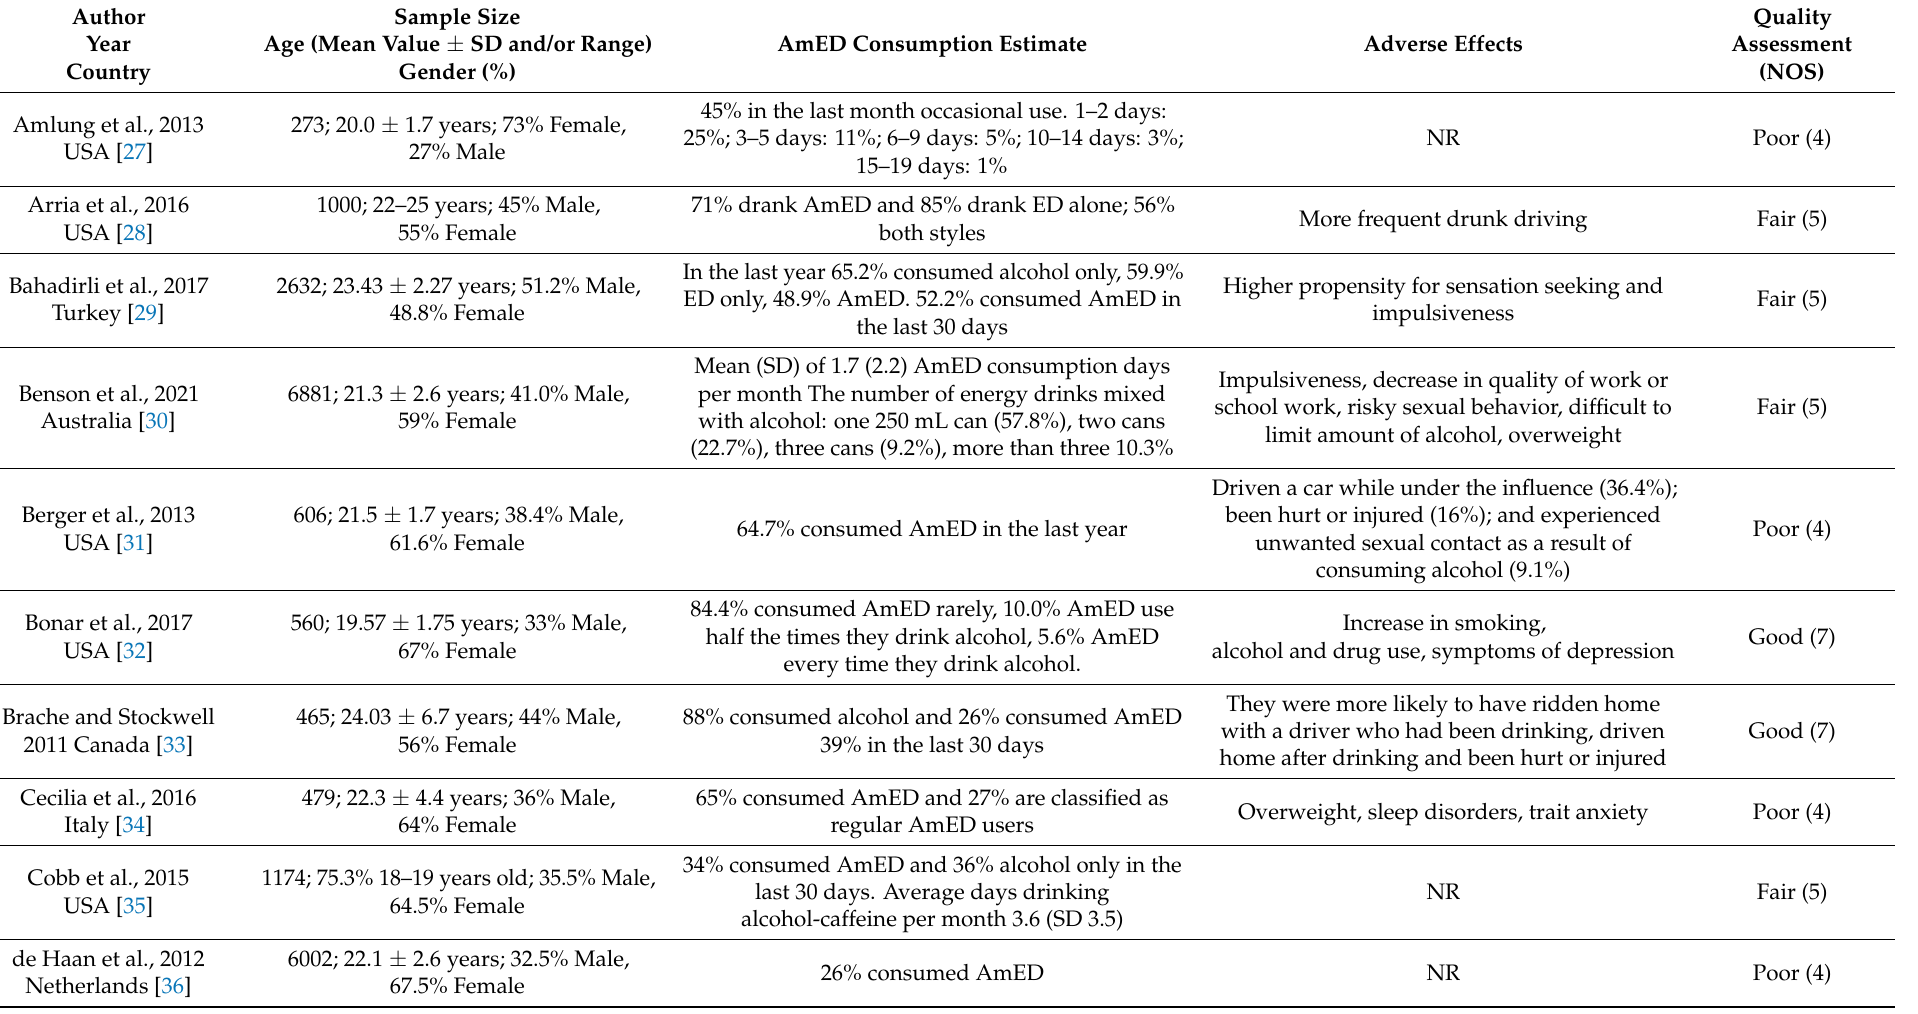
Table 3. Characteristics of the samples and main results related to Alcohol mixed with Energy Drinks (AmEDs) patterns of consumption in the selected